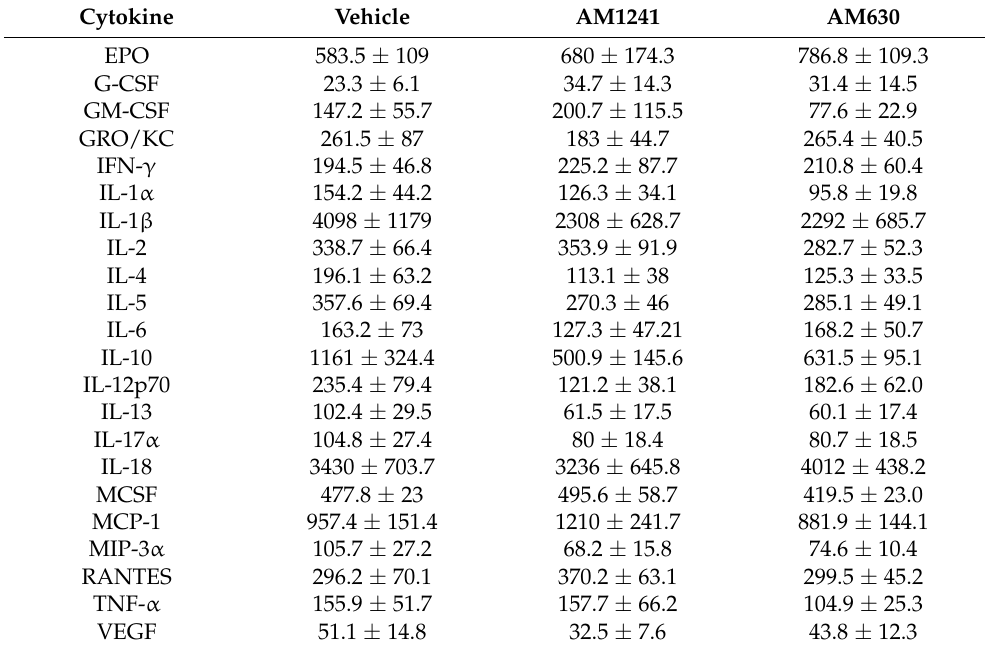
Table 2. Plasma cytokines following AM1241 or AM630 treatment in DIO rats. DIO rats were injected daily with AM1241 (3 mg/kg of body weight, ip), AM630 (0.3.mg/kg of body weight, ip), or vehicle for six weeks. All results are presented as a mean ± SEM from n = 6–9 (AM1241)-, n = 6–9 (AM630)-, and n = 6–9 (vehicle)-treated rats on an HFD in % concentration within range (ng/L) (exception n = 5–7 in G-CSF and